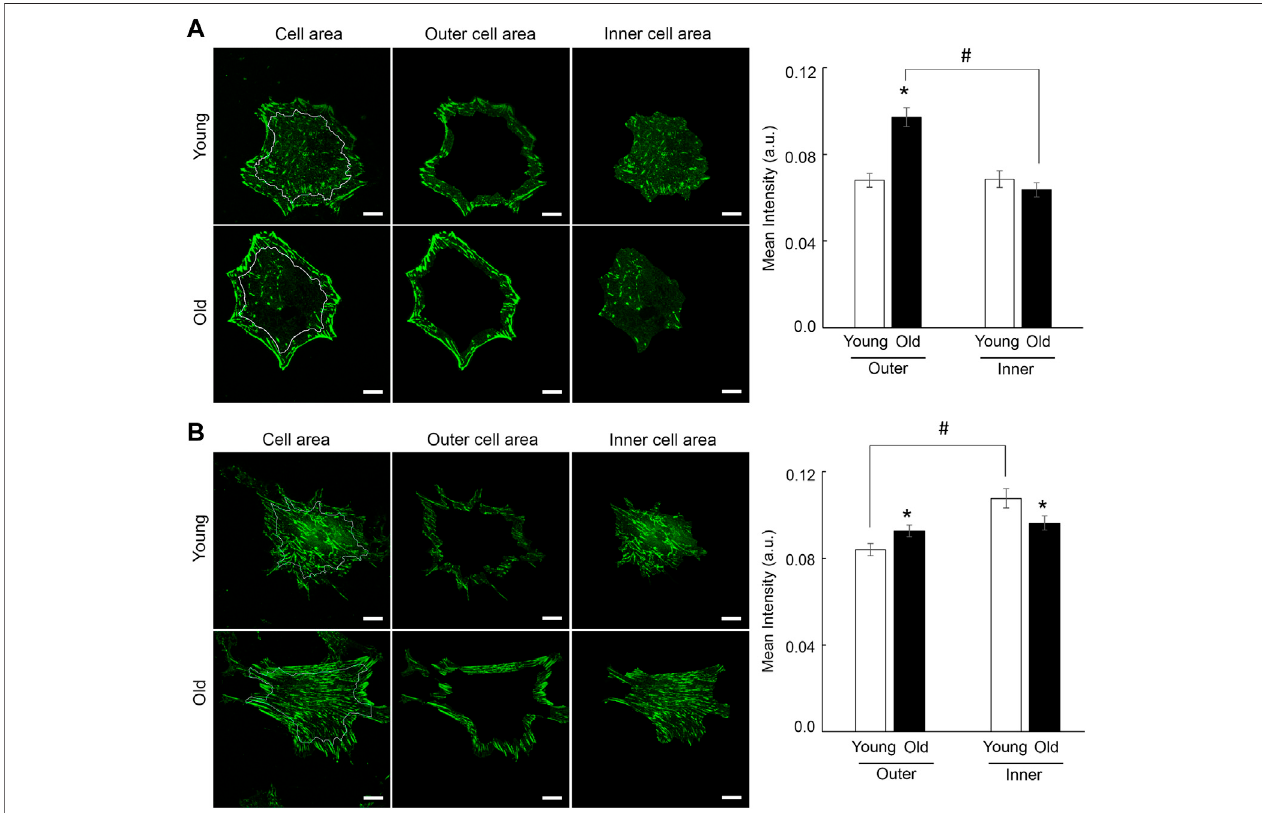
FIGURE7| RepresentativeconfocalimagesofVSMcellsplatedonsoftsubstratesfunctionalizedwith fi bronectin (A) and collagen-I (B) areshown.VSMcellshave been fl uorescently labeled for integrin β 1. Scale bar represents 10 μ m. Quanti fi cation of fl uorescence intensity relative to inner vs. outer cell area shows a strong recruitment of integrin β 1 at cell edges for old cells plated on fi bronectin ( n = 28 – 30), with a modest relative change for cells plated on collagen-I ( n = 40 – 50). Data are presentedasmean±SE.Signi fi cancewasevaluatedat p < 0.05.*Valuesaresigni fi cantlydifferentfromyoung.#Valuesaresigni fi cantlydifferentfromagematched VSM